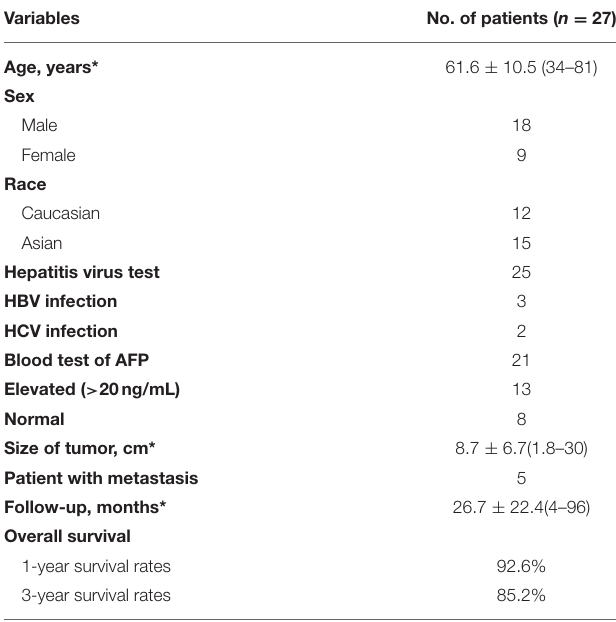
TABLE 2 | Summary of literature review